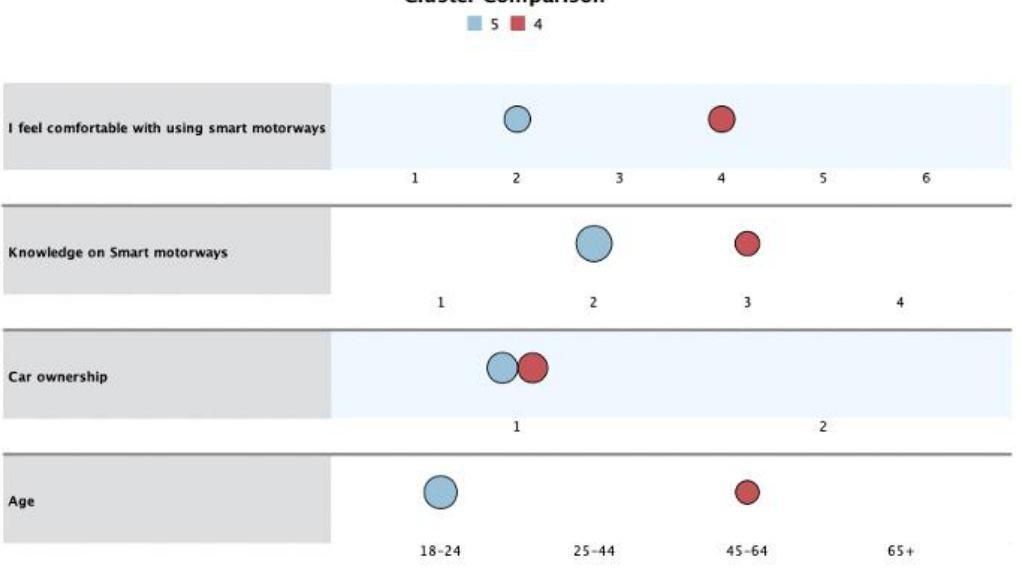
Figure 3 Lower knowledge of Smart Motorways and Age